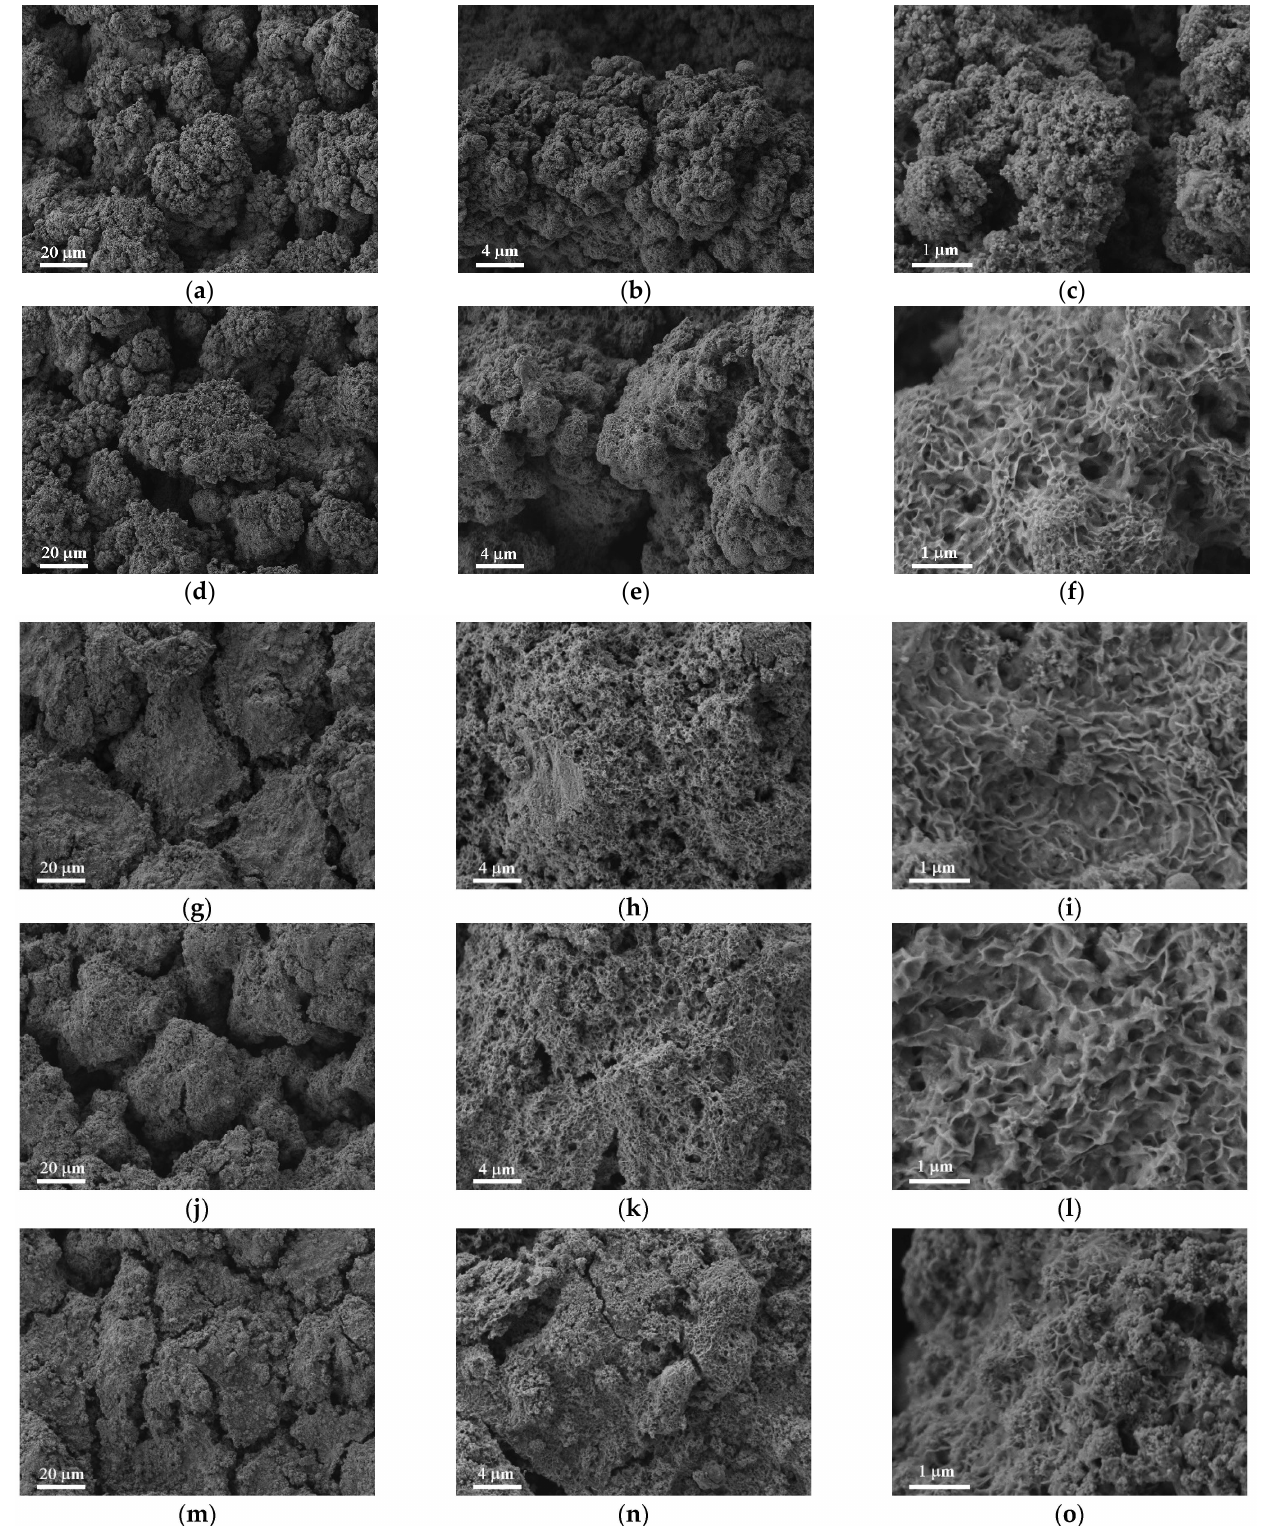
Figure 4. SEM images of the sample S4 with a laser-processed area of 20 × 80 mm 2 . Sequential rows (top to bottom) correspond to distances of 15 ( a – c ), 30 ( d – f ), 45 ( g – i ), 60 ( j – l ), and 75 ( m – o ) mm from the starting edge of laser scanning; columns correspond to different